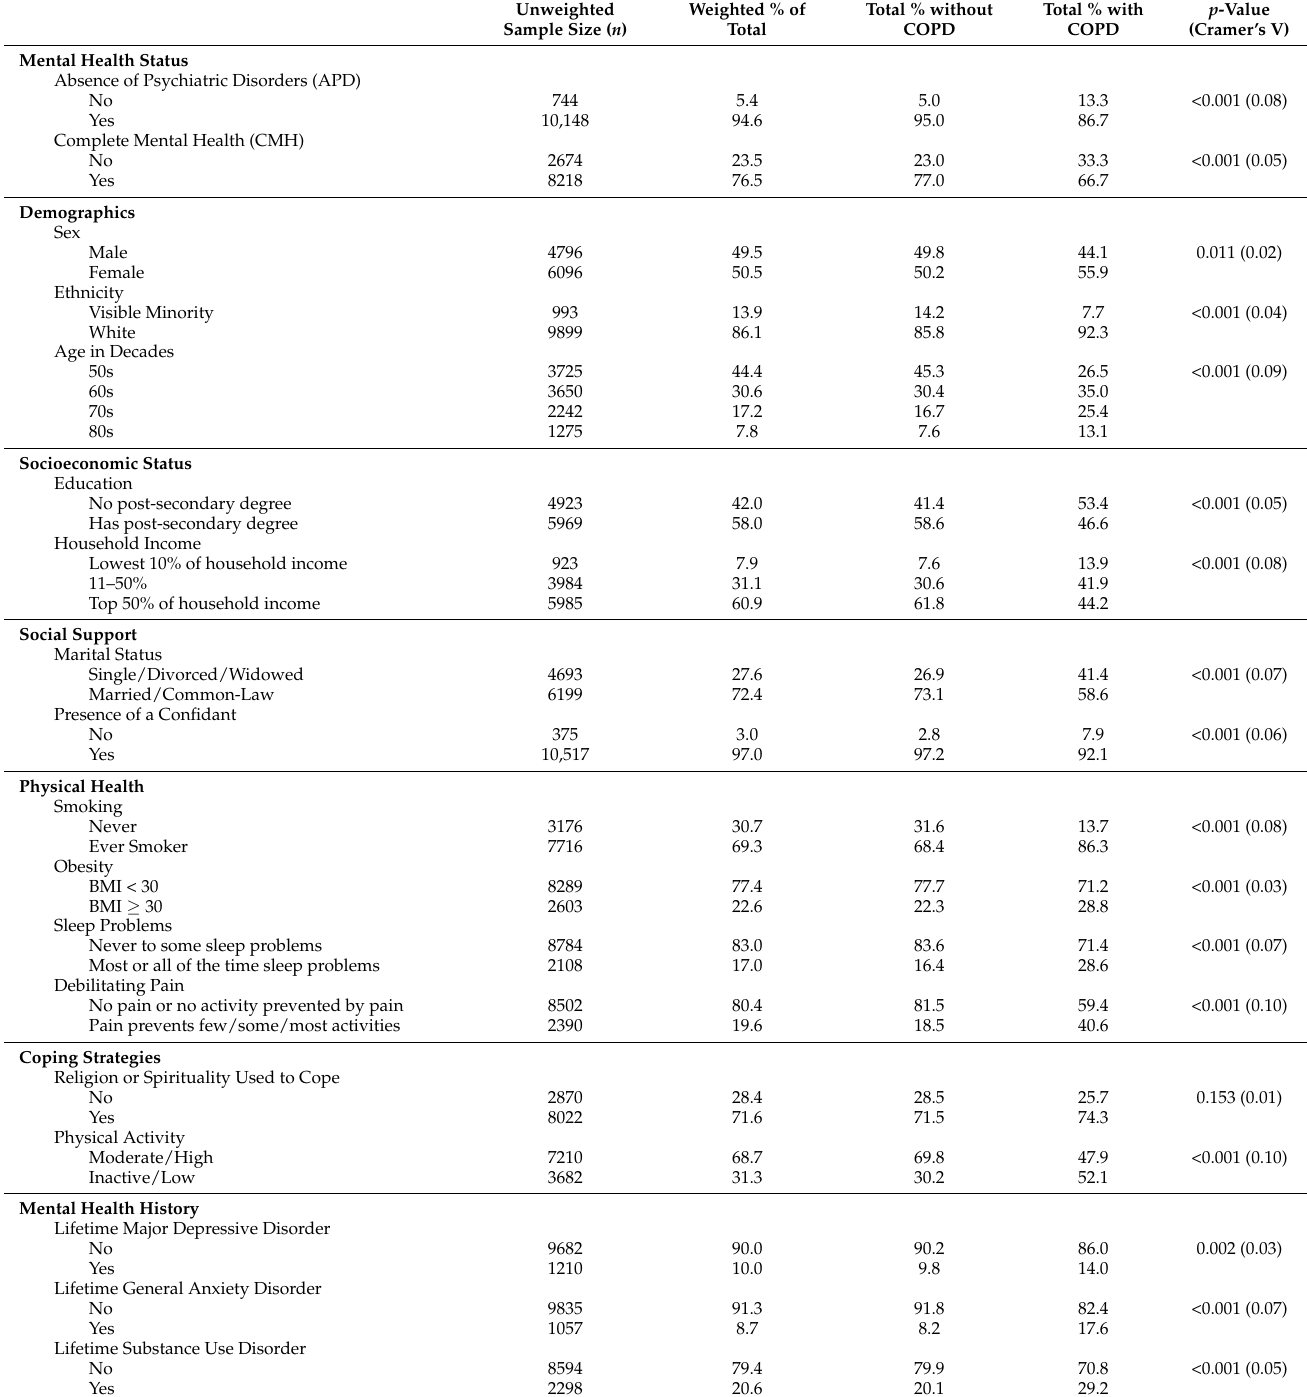
Table 1. Description of those with Chronic Obstructive Pulmonary Disease (COPD) and those without COPD in a Population-based Sample of Canadians aged 50 and older ( n = 10,892) Source: Canadian Community Health Survey-Mental